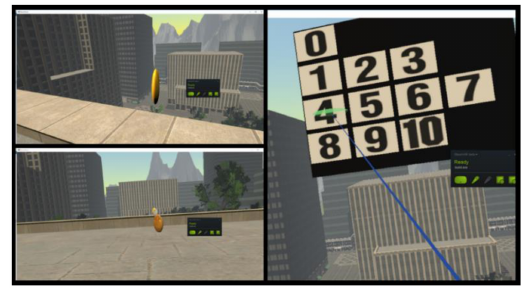
Figure 4. The VR acrophobia